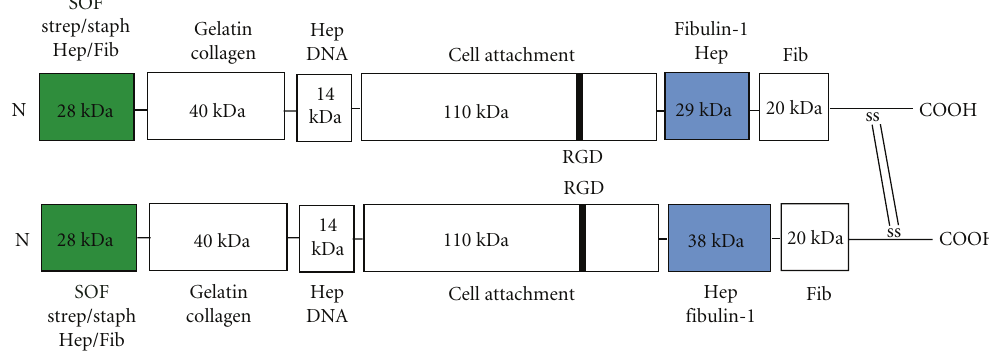
Figure 7: Model of fibronectin. Fibronectin (Fn) is a large, dimeric glycoprotein with multiple functional domains. The 28kDa N-terminal domain is the primary domain that interacts with most streptococci and staphylococci, but the collagen-binding domain may also interact with streptococci expressing protein F (or Sfb) [42]. SOF also binds to the N-terminal 28 kDa domain of Fn via the C-terminal, repeating peptide of SOF [40]. Fibulin-1 binds to the C-terminal, heparin-binding domain of Fn [43]. The interaction of streptococci with the N- terminal domain of soluble Fn is thought to induce a conformational change that exposes the RGD domain [44]. The RGD domain of Fn can then bind to integrins on the surface of host cells and tether the bacteria to the surface. Such interactions induce actin polymerization and promote internalization of the bacteria [45]. Streptococci and SOF can also bind to Fn that has already bound to surfaces. Hep: heparin, Fib: